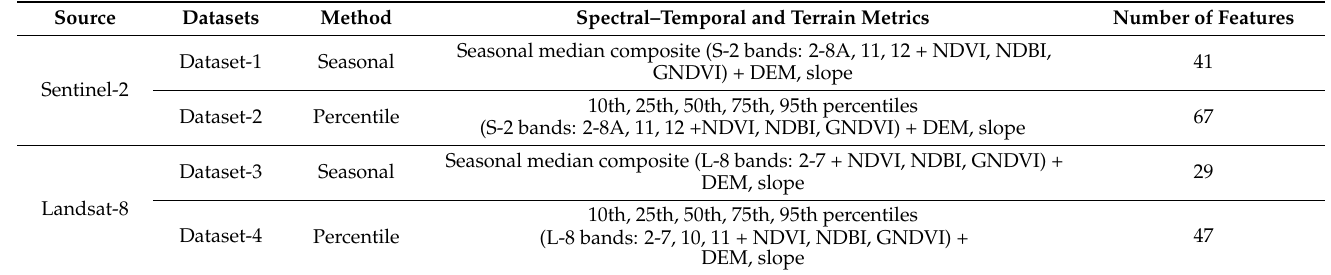
Table 2. Spectral–temporal and topography metrics used for the land use/land cover (LULC) classification. Spectral–Temporal and Terrain